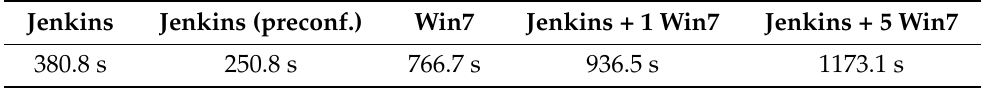
Table 2. Cloud deployment times for the